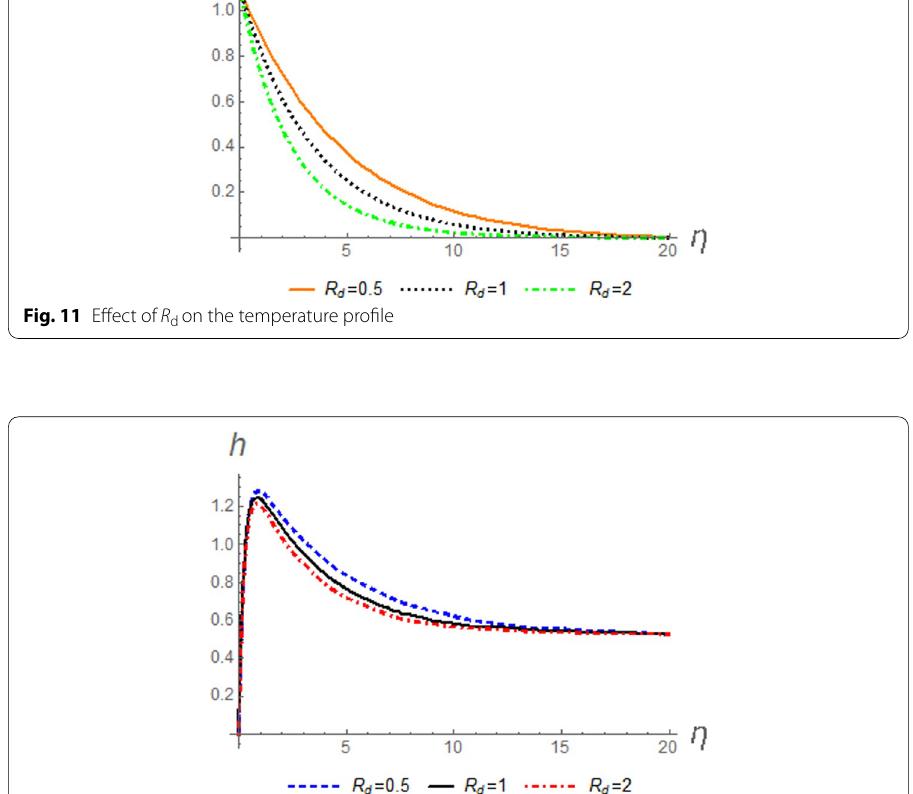
Fig. 12 Effect of R d on the velocity